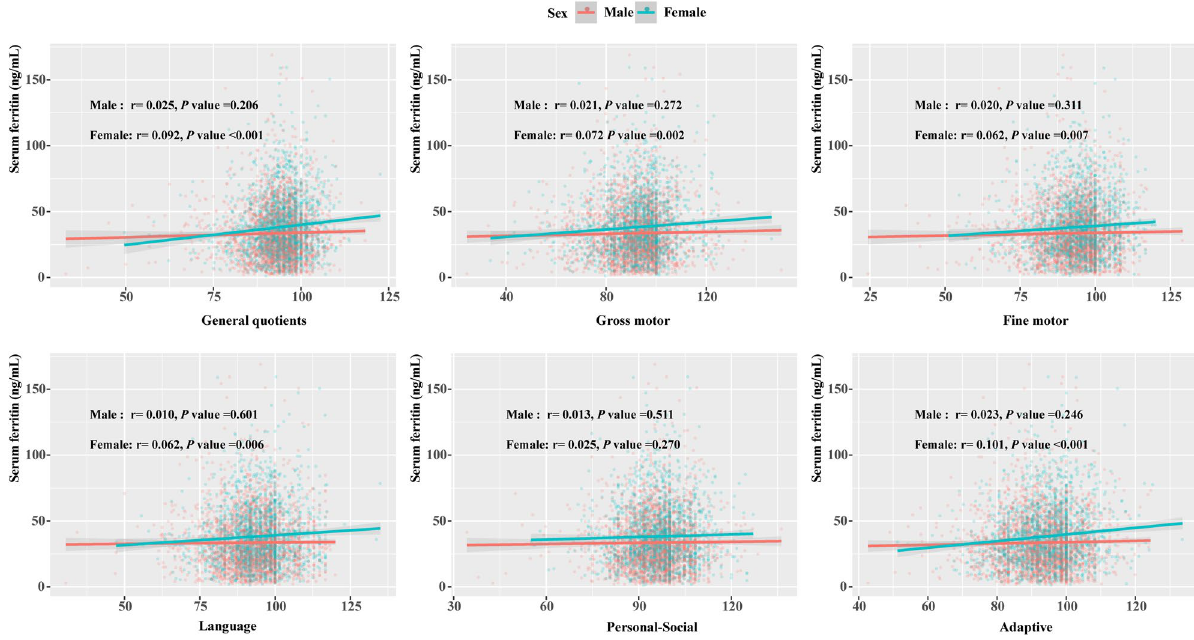
Figure 2. Correlations between CNBS-R2016 scores across domains and serum ferritin levels by sex. CNBS-R2016, Children Neuropsychological and Behavior Scale-Revision 2016.